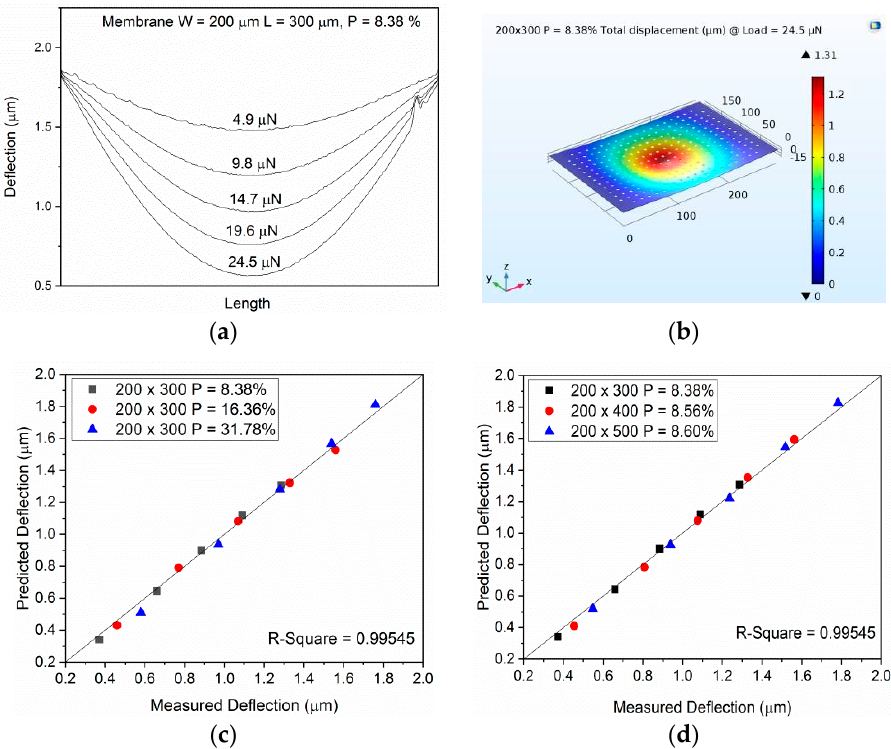
Figure 2. ( a ) Deflection profiles measured on a perforated membrane of sizes W × L = 200 × 300 μ m 2 and porosity 8.38%, under increasing loads; ( b ) FEA results of displacement under quasi point load of 24.5 μ N applied at the center of a membrane of sizes W × L = 200 × 300 μ m 2 , porosity of 8.38%. Predicted versus measured maximum deflection of different perforated membranes: ( c ) membrane W × L = 200 × 300 μ m 2 with increasing porosity; ( d ) three different membranes with same